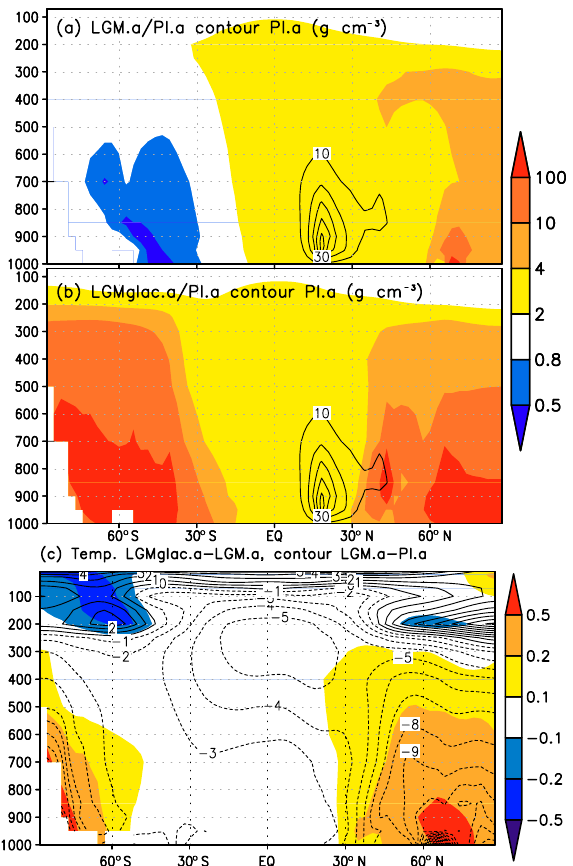
Figure 2. Dust emission flux (gm − 2 yr − 1 ) for (a) PI.a, (b) LGM.a, and (c) LGMglac.a. Ocean areas are dark grey and ice sheets are white.